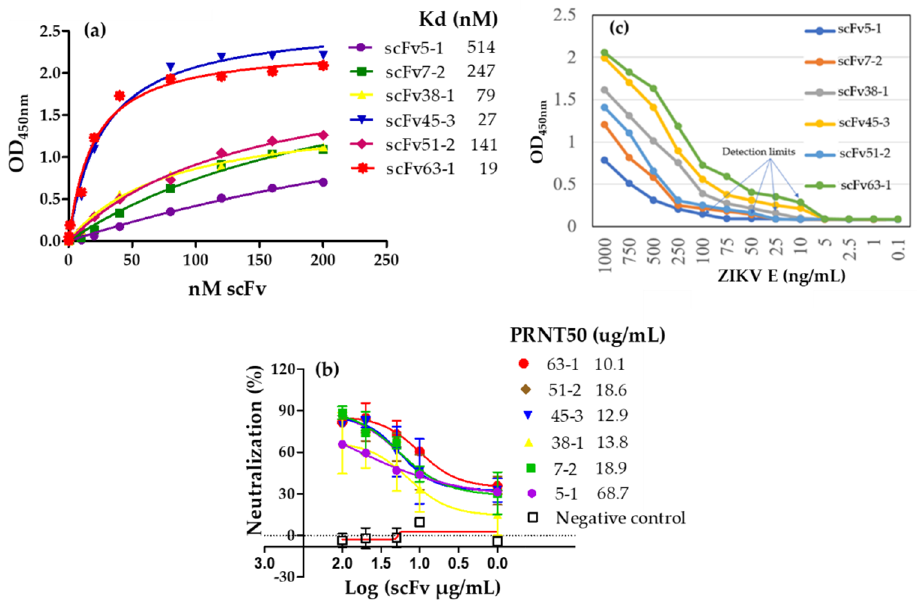
Figure 3. Zika envelope binding and neutralizing analysis of scFvs (adapted from Kunamneni et al. [101]) . ( a ) Binding curve of scFvs to Zika E by ELISA. ( b ) Plaque reduction of ZIKV PRVABC59 with antibodies (5-1, 7-2, 38-1, 39-2, 45-3 and 69-3). These data show the feasibility of generating neutralizing scFvs by ribosomal display [101]. ( c ) Antigen detection limits of the scFv were determined by antigen titration ELISA. About 10 ng / mL were detected by scFv45-3 and scFv63-1, ~25 ng / mL by scFv38-1, ~50 ng / mL by scFv7-2 and scFv51-2, and ~100 ng / mL by scFv5-1. scFvs against Zika E protein show that sub-nanomolar quantities of antigen can be detected with this method, suggesting that this approach can attain adequate sensitivity for diagnostic